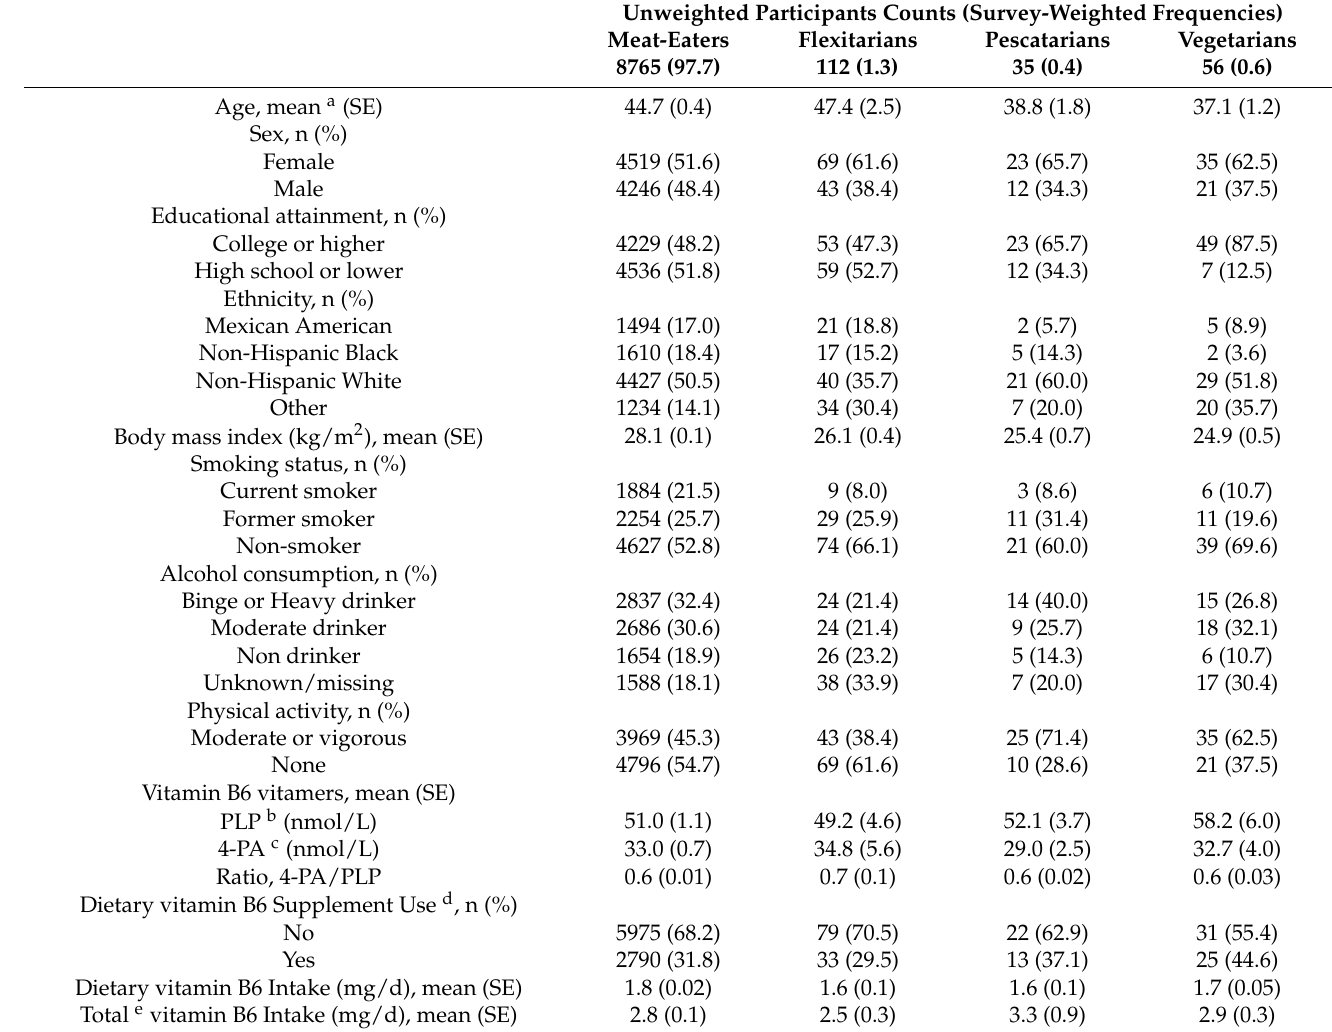
Table 1. Survey-weighted general characteristics of NHANES 2007–2010 study participants following a meat-eating, flexitarian, pescatarian or vegetarian diet (n =